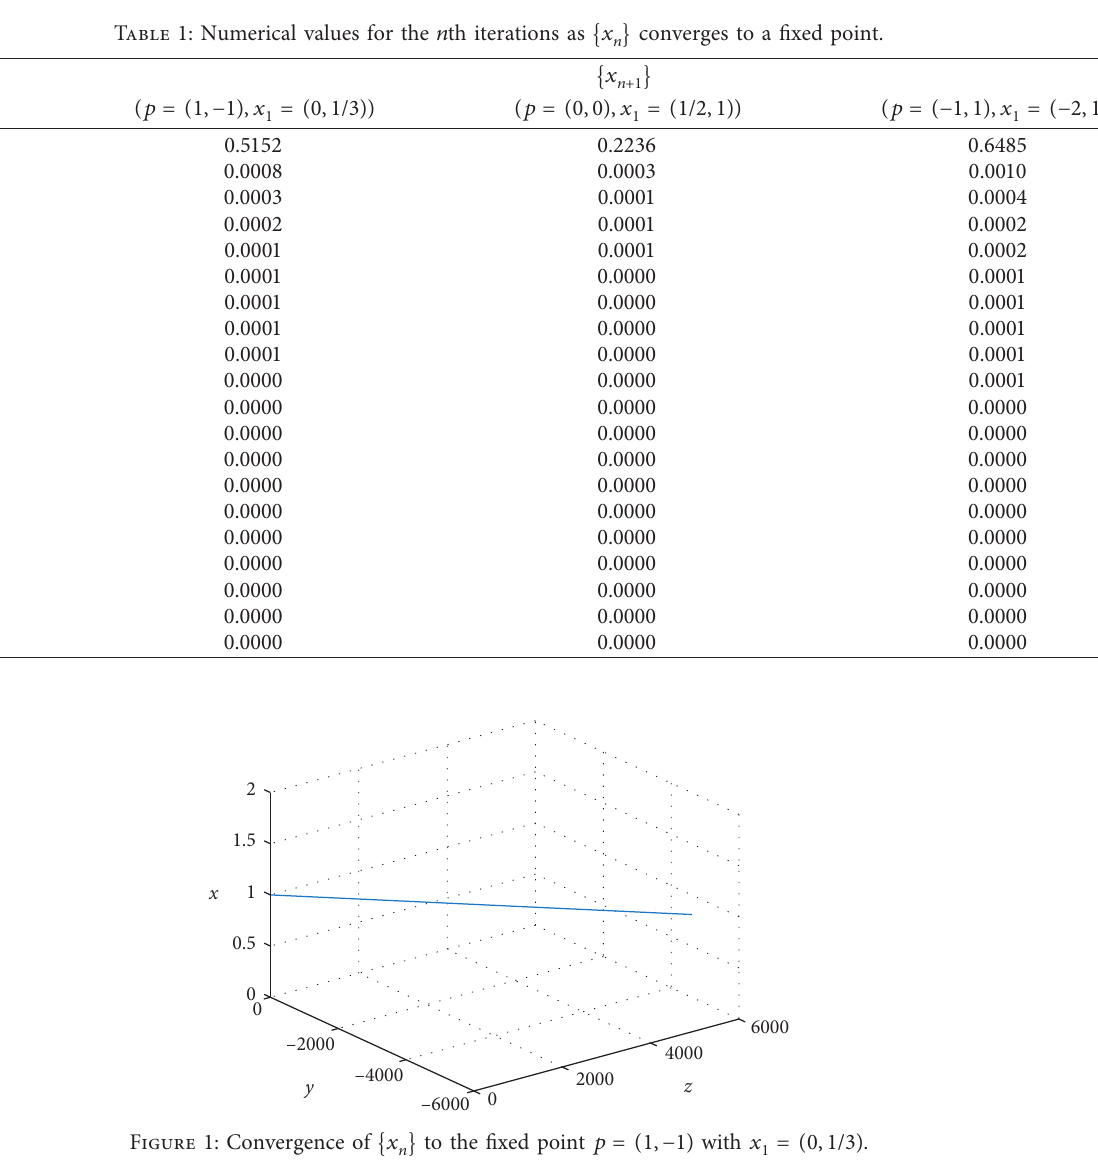
Table 1: Numerical values for the n th iterations as x